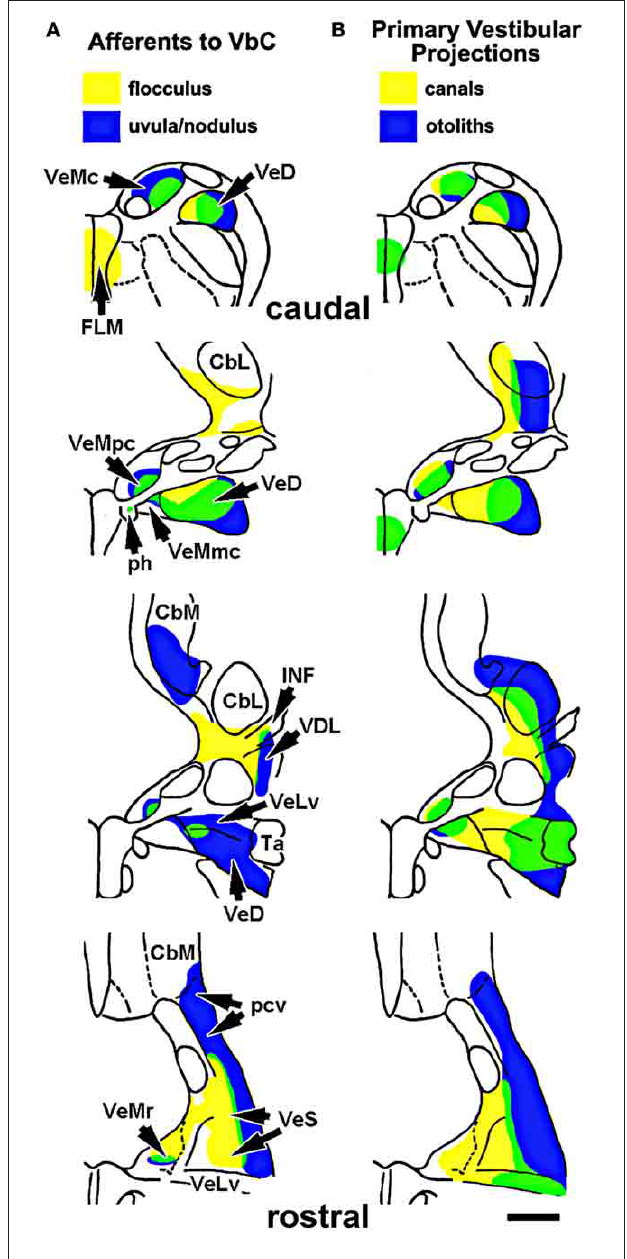
FIGURE 7 | (A) Shows the areas of the vestibular nuclei that project to the flocculus (yellow) and uvula-nodulus (blue). Green represents areas of overlap, which contains cells that project to the flocculus and the uvula/nodulus (based on Pakan et al., 2008). (B) Shows the areas of the vestibular nuclei that receive input from the otolith organs (blue) and semicircular canals (yellow). The areas in green receive input from both the semicircular canals and otolith organs (based on Schwarz and Schwarz, 1983 and Dickman and Fang, 1996). Abbreviations: VeMc, r, pc, mc: the caudal, rostral, parvocellular, and magnocellular divisions of the medial vestibular nucleus; VeD: descending vestibular nucleus; FLM: medial longitudinal fasciculus; ph: prepositus hypoglossi; CbM: medial cerebellar nucleus; CbL: lateral cerebellar nucleus; INF: infracerebellar nucleus; VDL: dorsolateral vestibular nucleus; VeLv: lateral vestibular nucleus, ventral division; Ta: tangential nucleus; pcv: cerebellovestibular process. Scale bar =